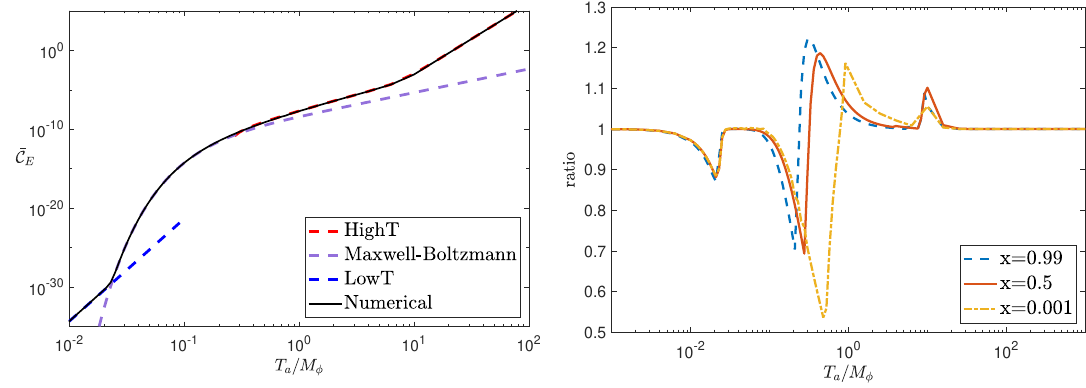
Figure 16. Left Panel: total energy transfer collision term C E =M 5 as a function of T a =M (cid:30) (cid:30) at (cid:12)xed x = T b =T a = 0 : 5. The black solid line corresponds to C E numerically evaluated using eq. (C.12) with scattering amplitude given by eq. (C.39), the red dashed line corresponds to C high-T (eq. (C.43)), the purple dashed line corresponds to C MB (eq. (C.45)) and the blue dashed line corresponds to C low-T (eq. (C.46)). Right Panel: ratio of our analytic estimate as given in eq. (C.47) to the numerically evaluated collision term as a function of T a =M (cid:30) for (cid:12)xed temperature ratios T b =T a = x = 0 : 99 ; 0 : 5 ; 0 : 001. Here we (cid:12)x (cid:3) a = 100 M (cid:30) , 1 = (cid:3) b = 0 : 5 and m a;b = 10 (cid:0) 8 M (cid:30) 1 = (cid:3) a